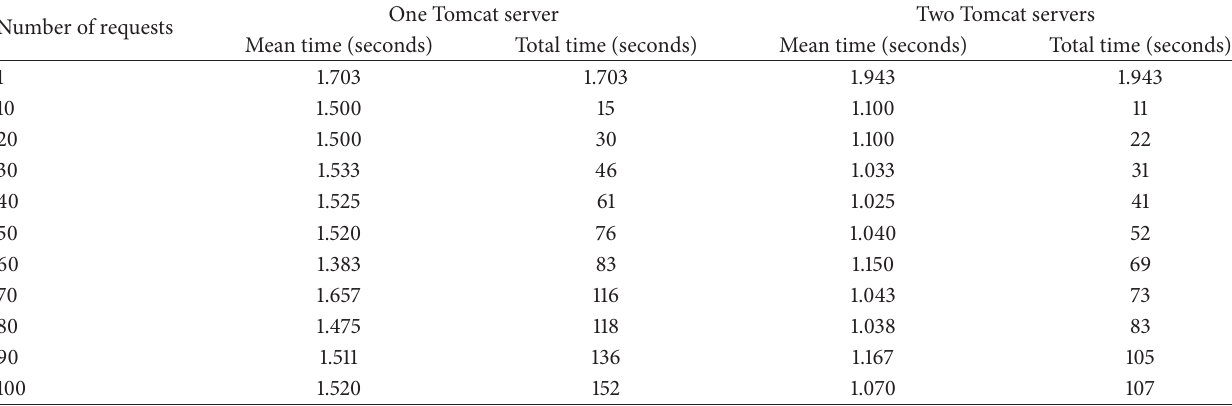
Table 1: Times required to submit different numbers of requests within 1 second when using the SSL